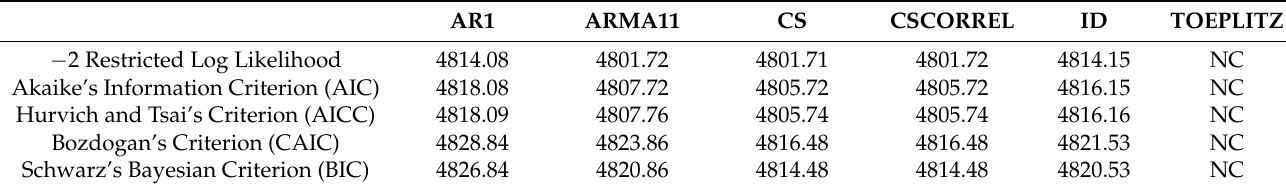
Table 3. Information on the different covariance structures.